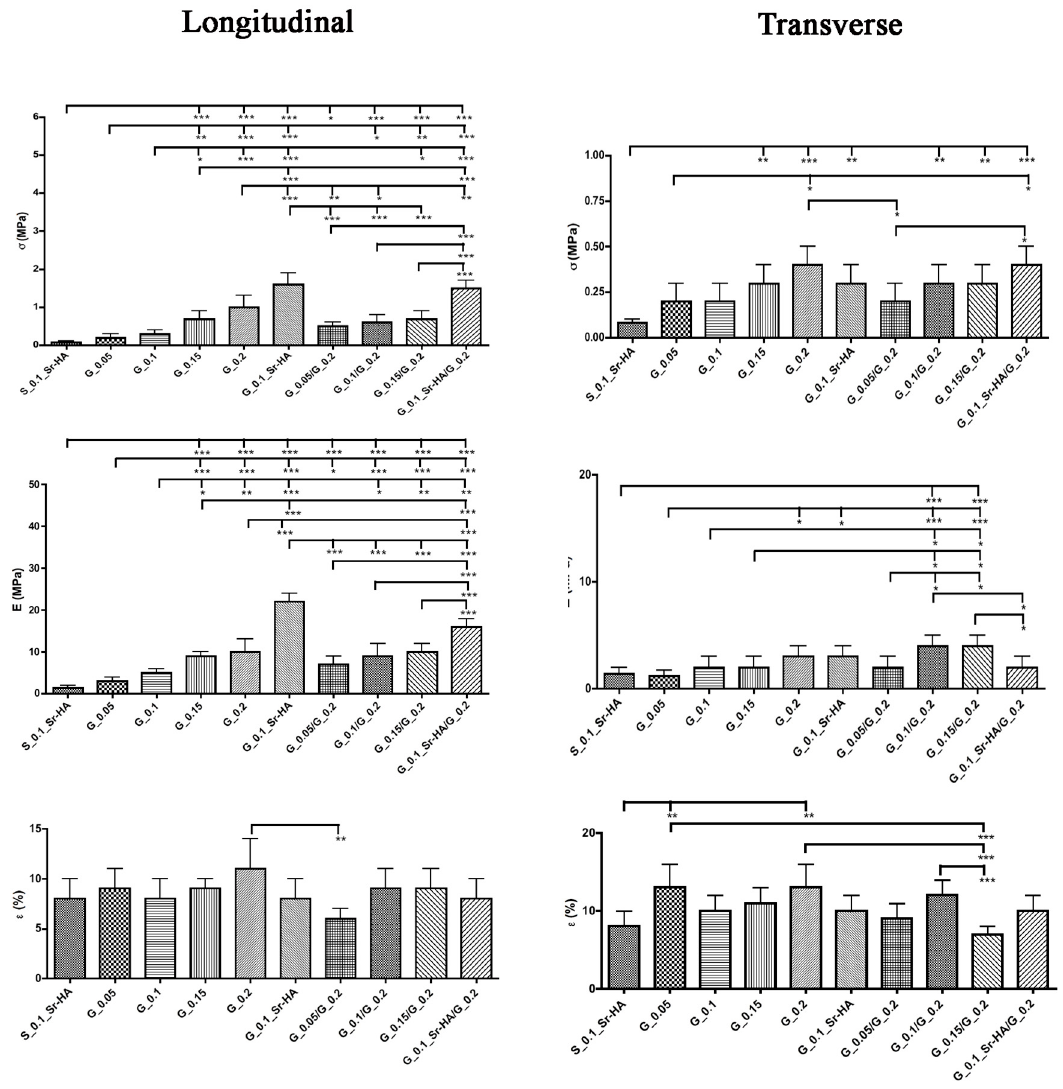
Figure 4. Mechanical properties in compression, measured in longitudinal and transverse direction. Values of maximum stress at break ( σ ), Young’s modulus (E) and elastic deformation ( ε ) are reported. Each value corresponds to the average of 6 determinations and it is reported with its own standard deviation and statistical analysis. Significant differences (one-way ANOVA) in σ (MPa), E (MPa) and ε . Asterisks (* p < 0.05, ** p < 0.01 and *** p < 0.001) indicate results of post-hoc test (Tukey).